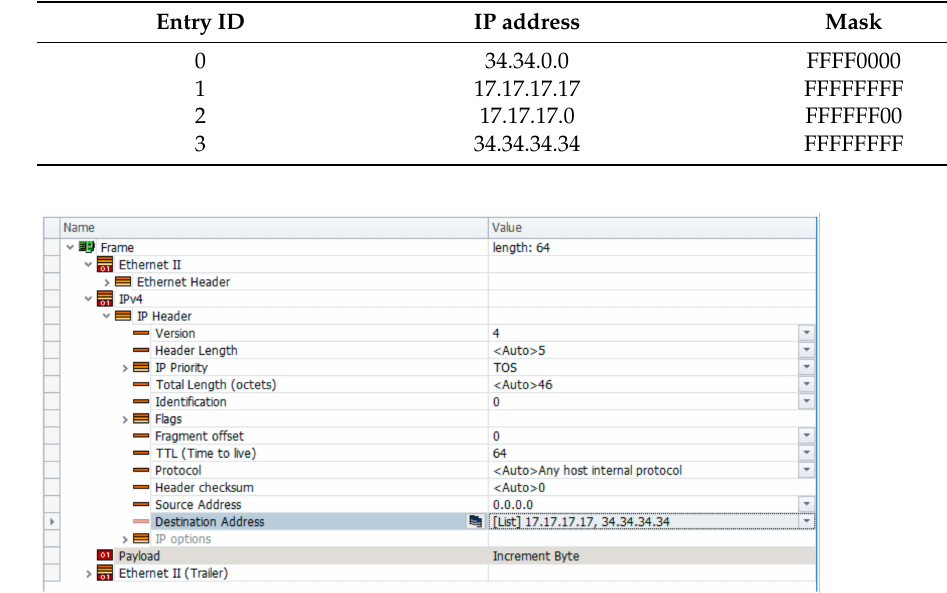
Figure 19. Ixia packet editing